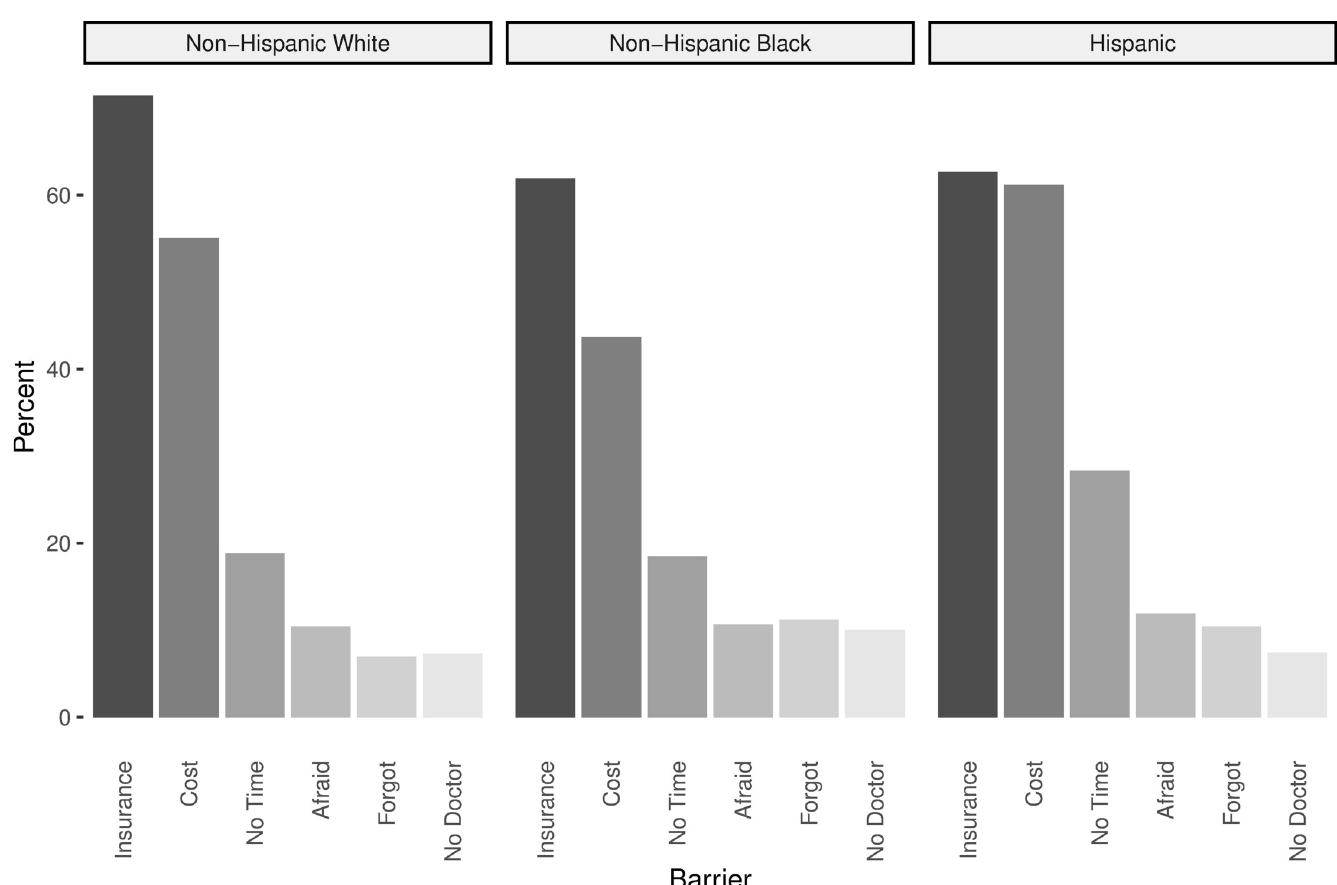
Fig 1. Barriers to cervical cancer screening by race and ethnicity. Responses could be coded as multiple barriers. Other barriers reported less frequently include unsure, don’t need, transportation, didn’t want, missed appointment, not comfortable, not offered, not covered, and spousal opposition.